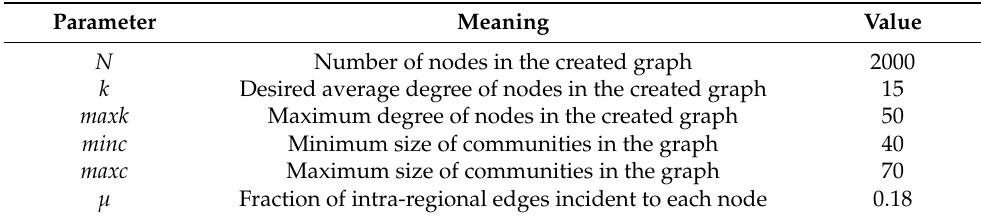
Maximum size of communities in the graph